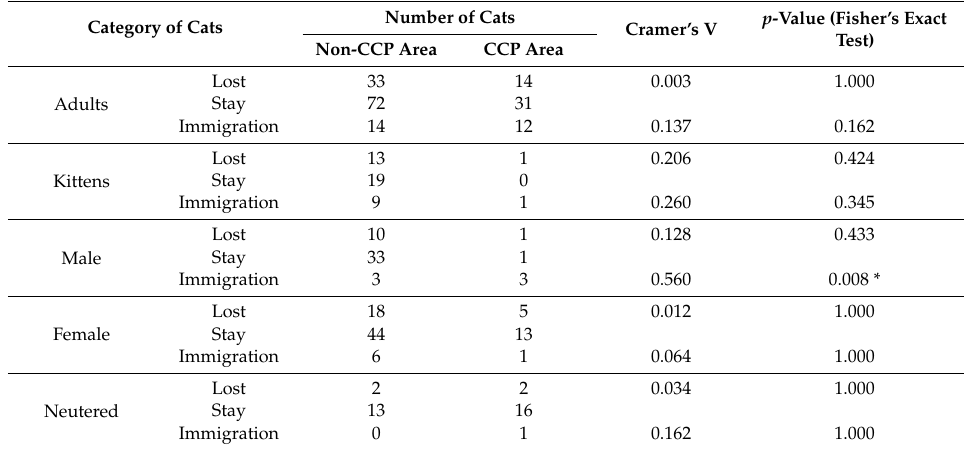
Table 1. Number of cats that were lost, stayed, and immigrated from Year 1 to Year 2 in the community cats program (CCP) and the non-CCP